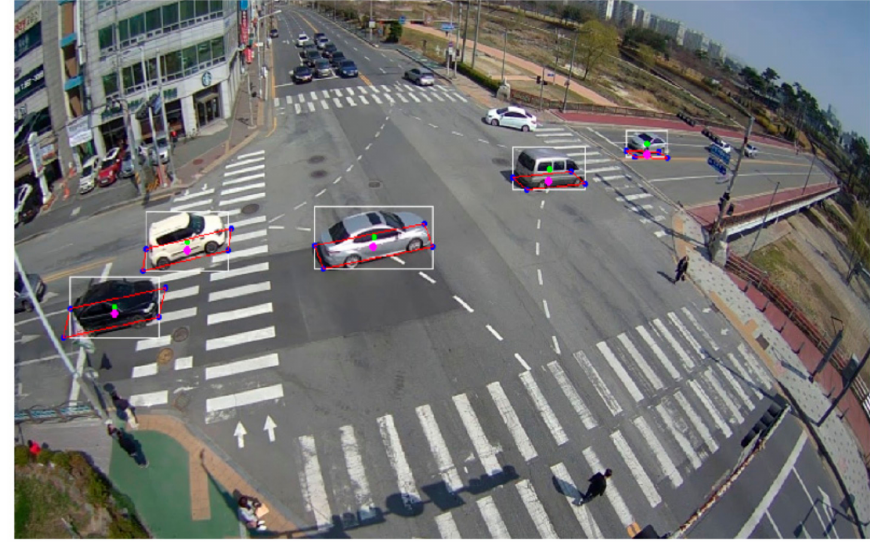
Figure 11. Example of the extracted bounding boxes of moving